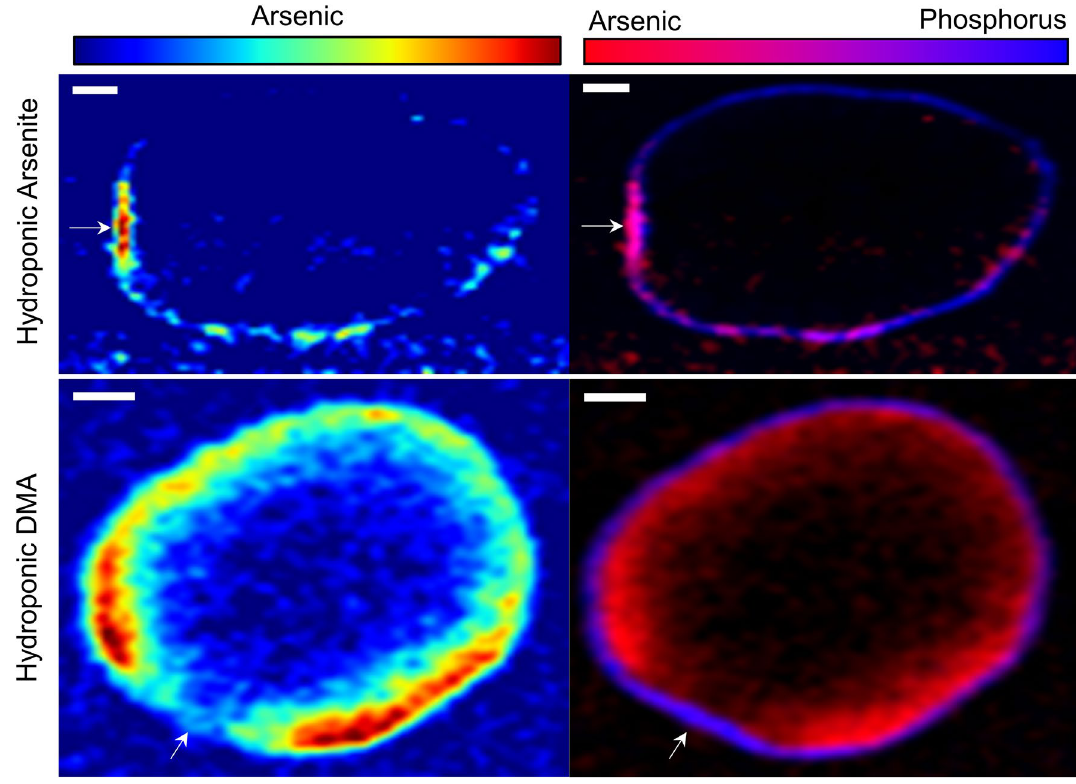
Figure 1. Distribution of As (left) and colocalization (right) of As (red) and P (blue) in rice grains grown hydroponically receiving either arsenite (8 uM) or DMA (5 uM). In the grain receiving arsenite, As is mainly located in the bran and the OVT (arrow) as shown by purple hues in the bicolor plots. In the DMA treatment, As permeates into the endosperm and is notably low near the OVT (arrow). Scale bar is 300 μm.